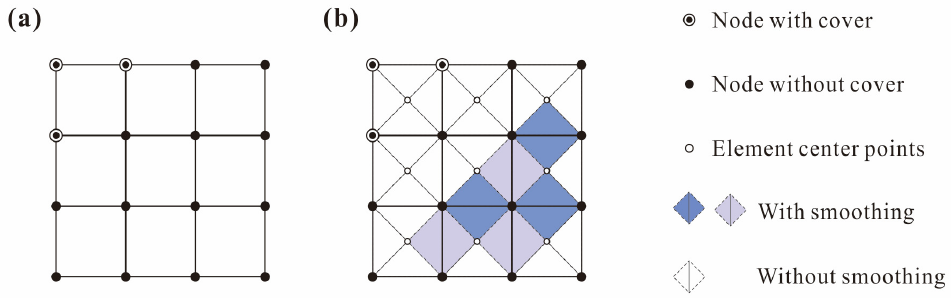
Figure 4. Adaptive use of cover function for the edge-based smoothed finite element: ( a ) Finite element mesh with cover functions, ( b ) application of the edge-based smoothing scheme to elements without cover functions.